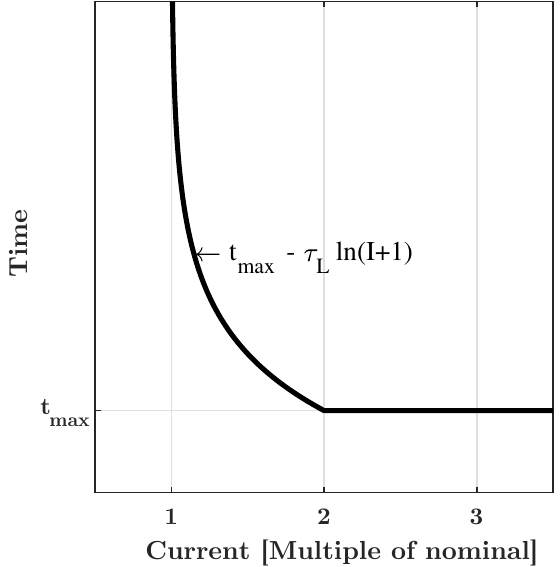
Figure 17. Proposed time-current characteristic for the plug-and-play protection scheme, where t max is the maximum time that the SSCB needs to detect and interrupt an